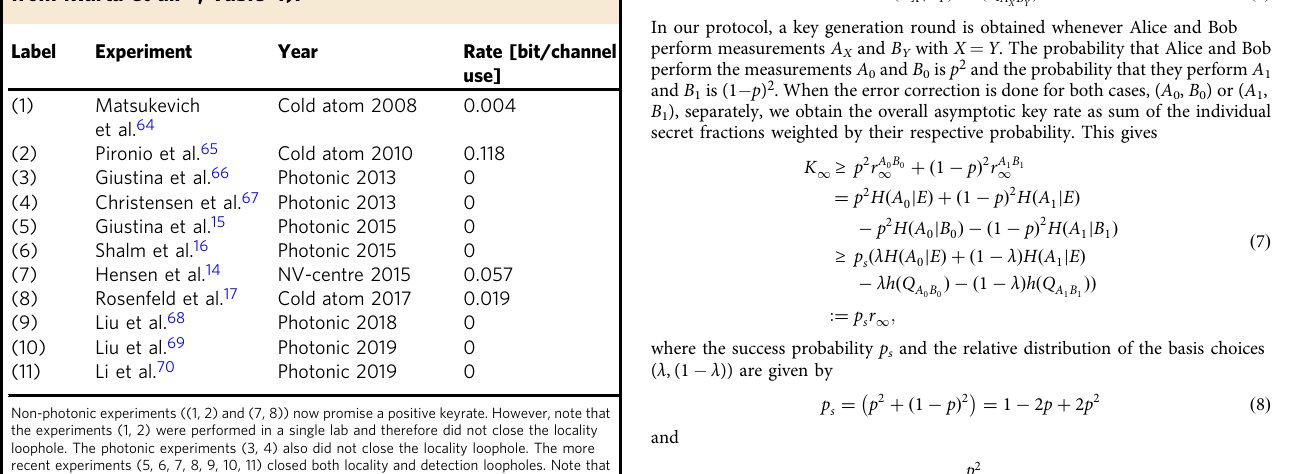
Table 1 Asymptotic rates for existing experiments (data from Murta et al. 18 , Table